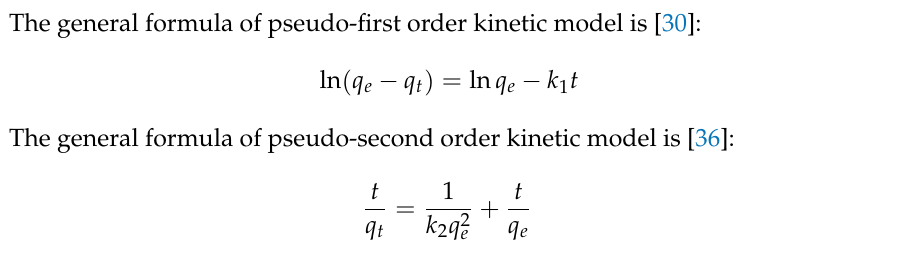
Table 3. Adsorption kinetic models for vanadate adsorption by Mg-Fe-Ti-LDHs-Cl - -2, Mg-Fe-Ti- LDHs-CO 32− and Mg-Fe-Ti-CLDH.